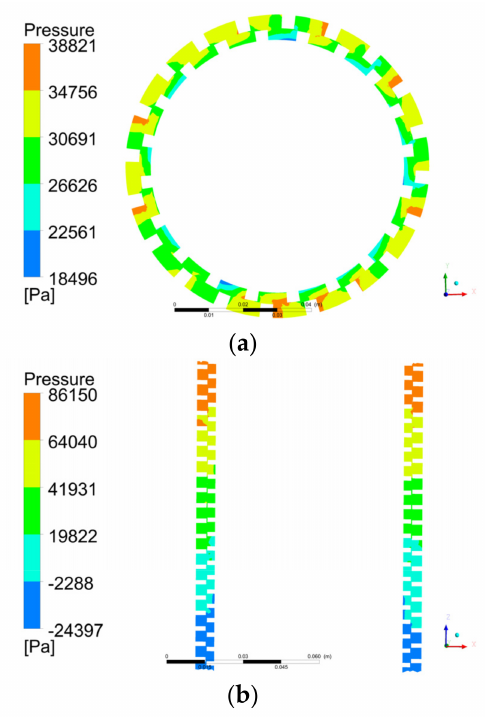
Figure 11. Contours of pressure distribution in the pump on the ( a ) XY and ( b ) XZ